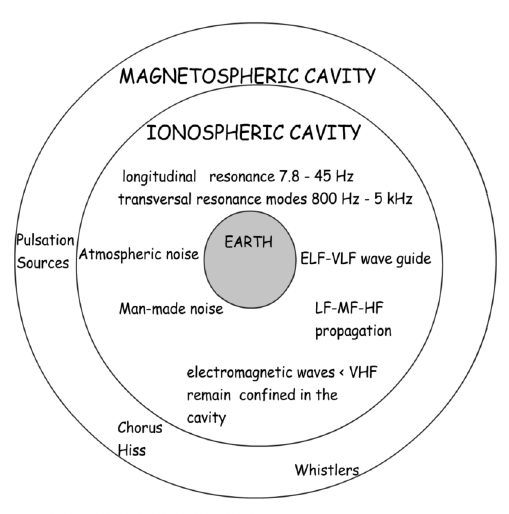
Fig. 1. A schematic representation of terrestrial nat- ural and man-made radio noise sources within the magnetosphere-ionosphere